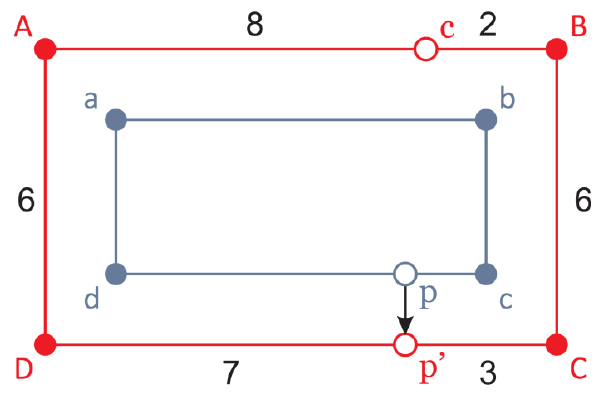
Figure 12. Shelves and aisles graphs: { a , b , c , d } is the set of vertices of the shelves graph with the product location p on the edge ( c , d ) and { A , B , C , D } is the set of vertices of the aisles graph with cart location c on the edge ( A , B ). The product location is mapped to the aisles graph as p’ and the shortest path from cart to product is ( c , B , C , p’ ) with length 11.